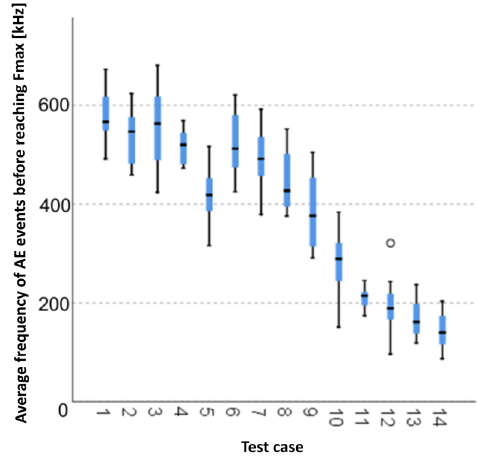
Figure 14. Graphic presentation of the Kruskal–Wallis test results for independent samples: average frequency of AE events before reaching F max .